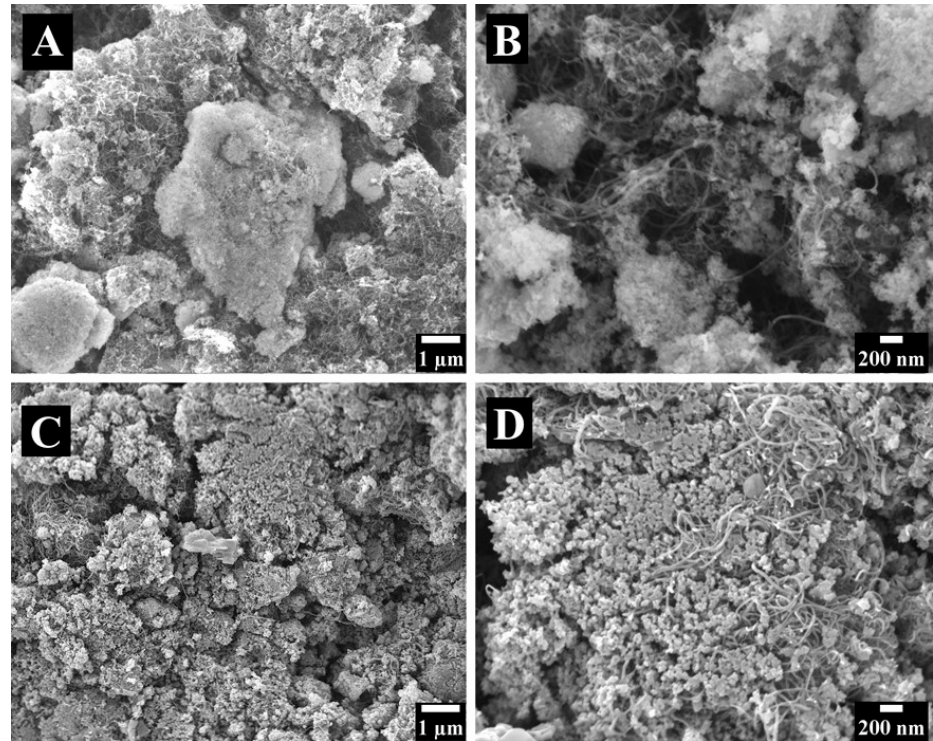
Figure 4. SEM images of different magnifications for electrodes prepared using ( A , B ) chlorogenic acid and ( C , D )